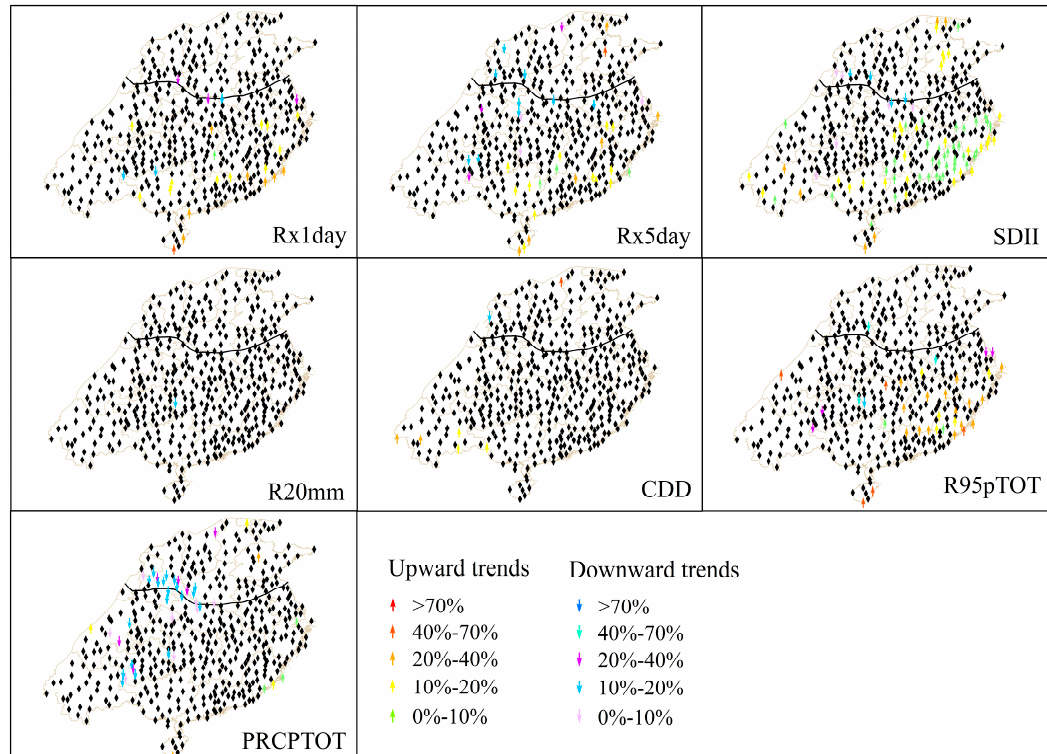
Figure 12. Spatial distributions of the trend magnitudes for the extreme precipitation indices at a 30-year scale during the growth period of October 1961 to May 2016. The black rhombus represents insignificant trends, and the trend magnitude fails to pass the significance test of p = 0.05. The colored arrows indicate that the trend magnitude has passed the significance test of p = 0.05.